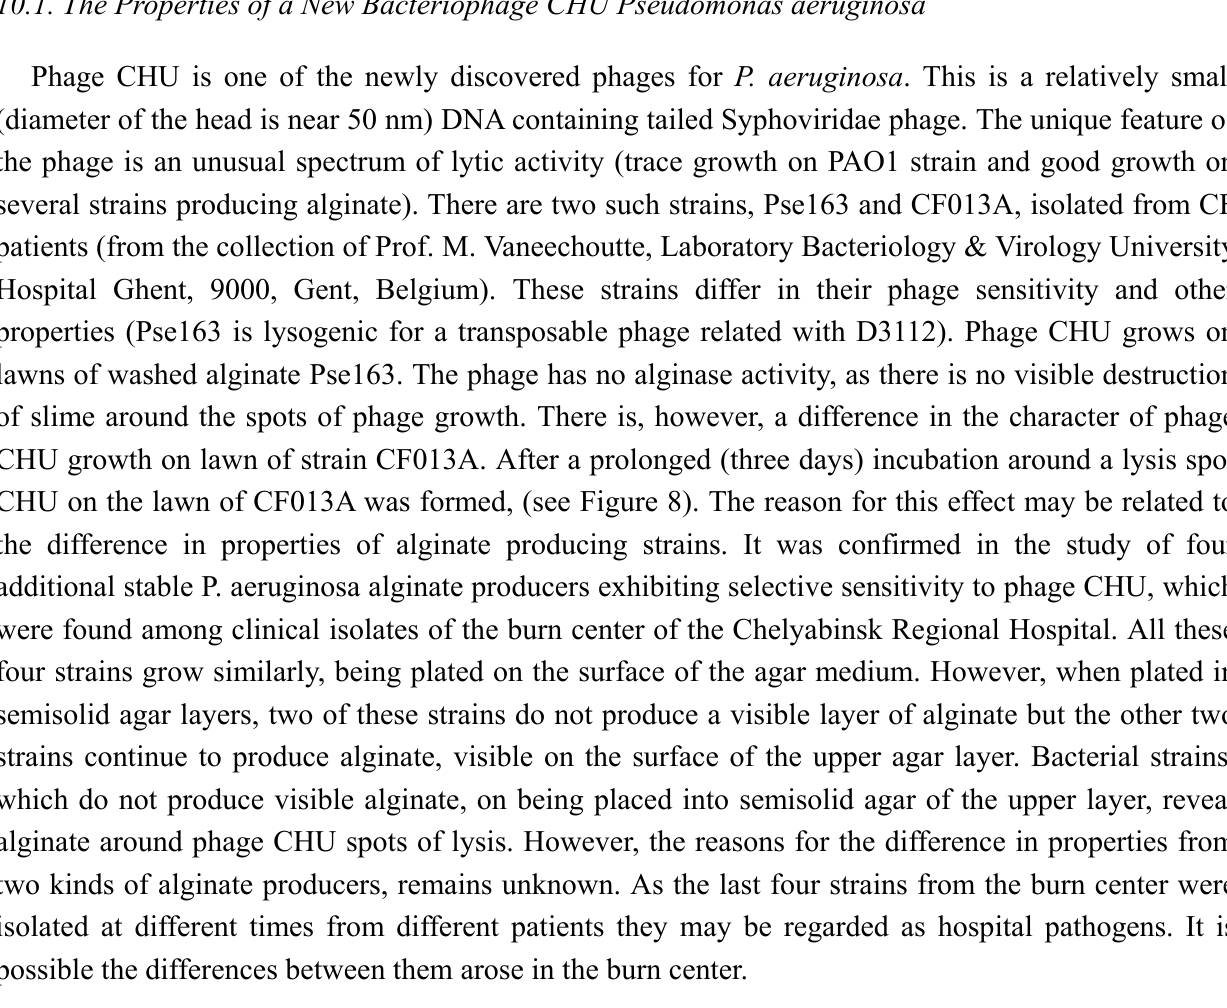
Figure 8. The raised slimy ring on the CF013A lawn around the phage CHU lysis